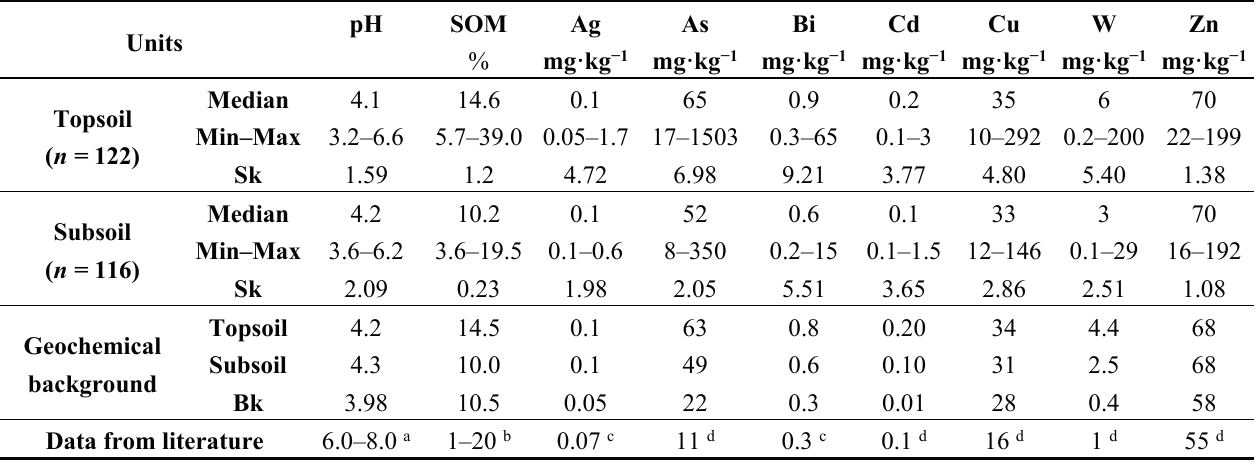
Table 4. Median, minimum and maximum concentrations values of topsoil and subsoil samples from Panasqueira mine and surrounding environment compared with international data. Casegas area, considered as representative of geochemical background